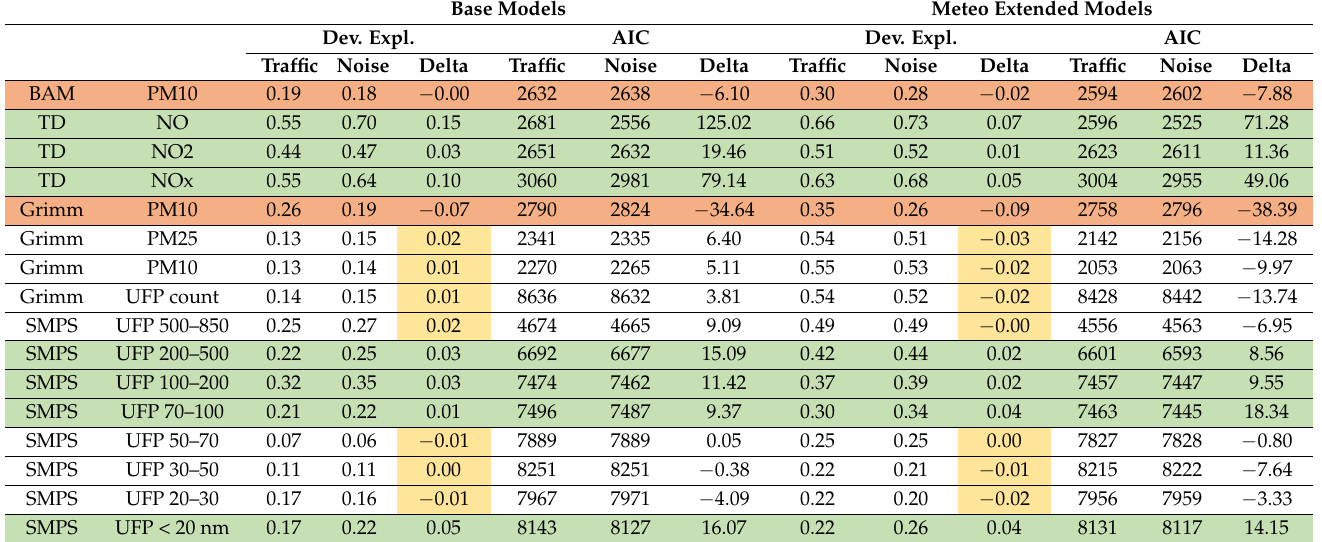
Table 4. Comparison of the traffic and noise models in two variants, base and meteo extended. Green indicates improvement with the noise-as-a-proxy approach, red is failing, and orange is